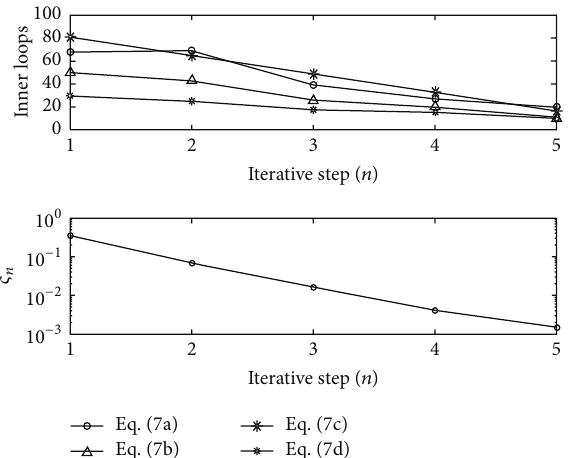
Figure 9: Inner loops and iterative deviation vary from iterative steps 𝑛